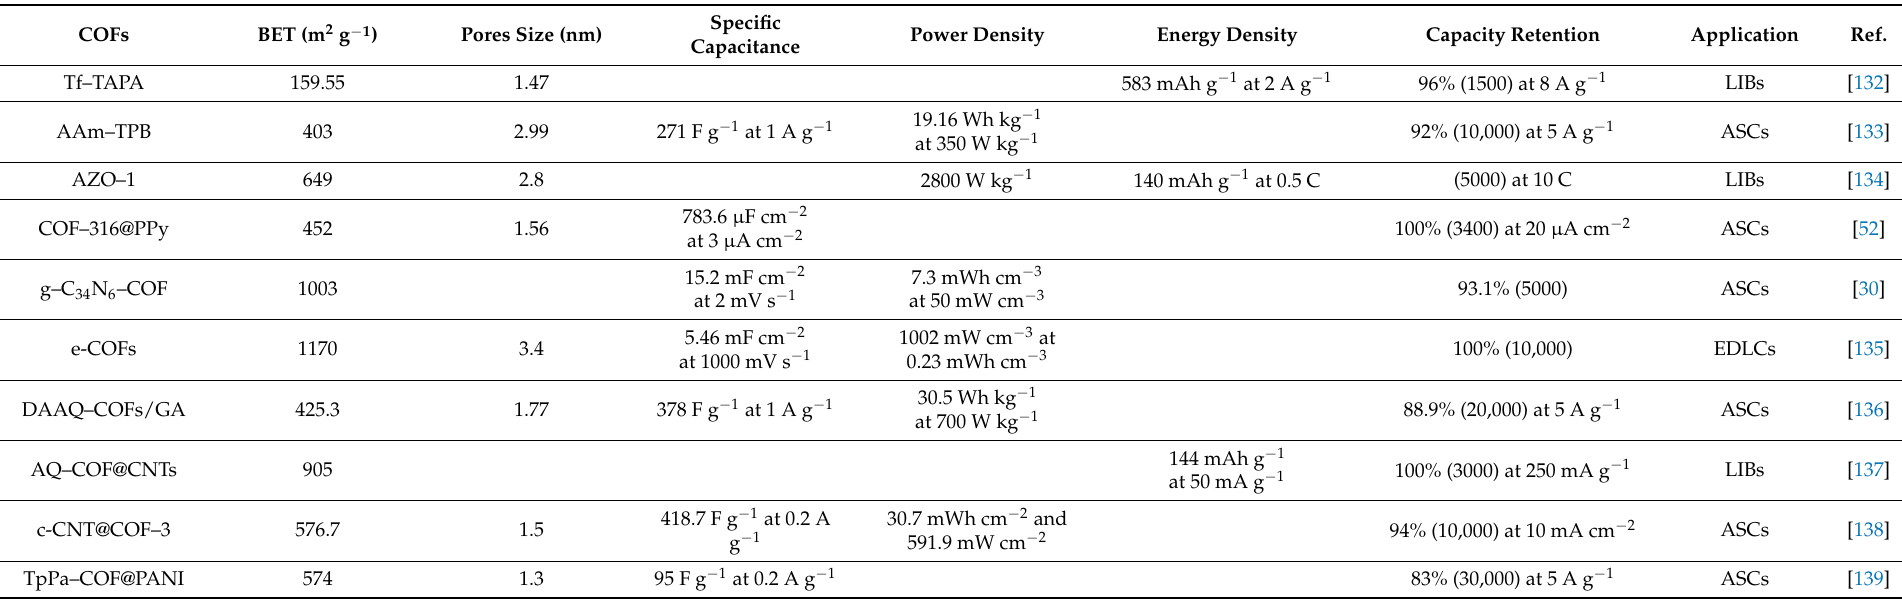
Table 1. COF-derived electrode materials and their electrochemical